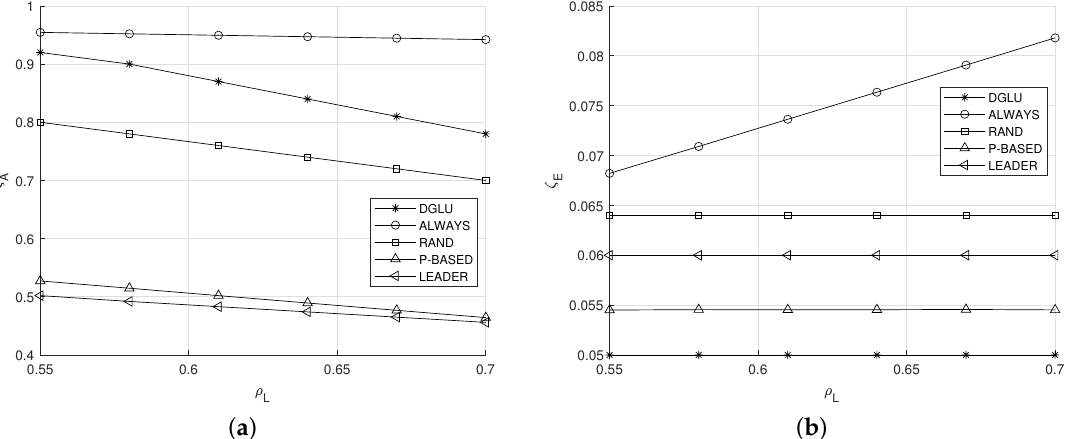
Figure 5. Effect of the location change probability ρ L . ( a ) Average location accuracy ζ A . ( b ) Average energy outage probability ζ E